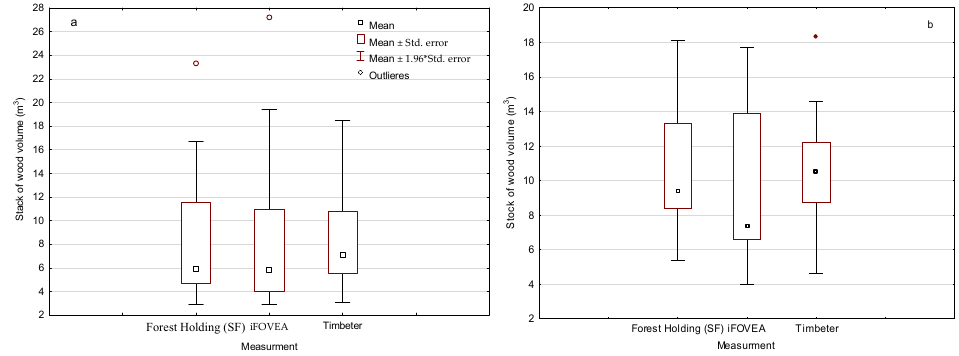
Figure 5. Statistical characteristics of the volume of a single pile by method of measurement. ( a ) broadleaf wood; ( b ) coniferous wood.